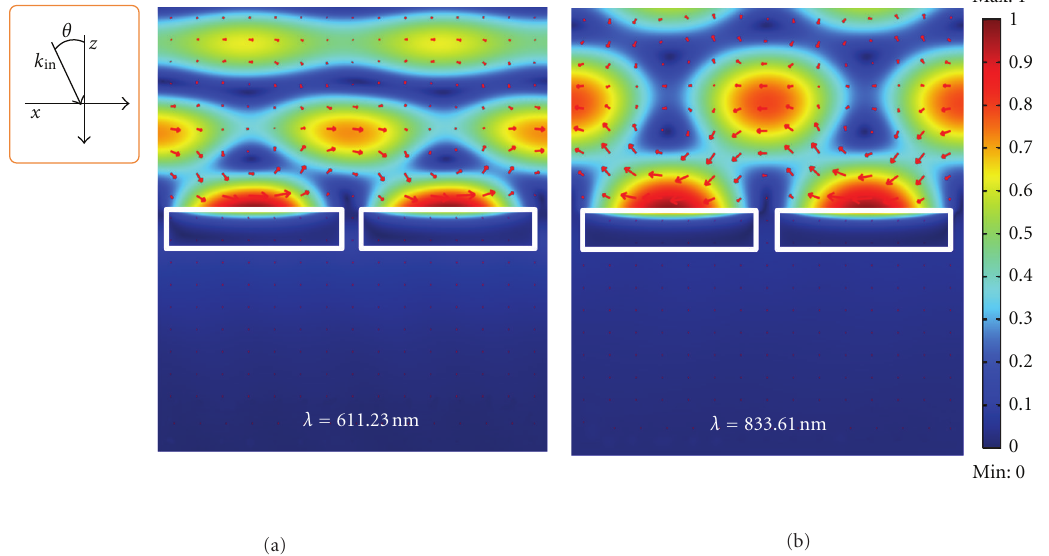
Figure 6: Absolute value of the magnetic field for the structure described in Figure 5 with θ = 10 ◦ computed at (a) λ = 611.23 nm and (b) λ = 833.61 nm. Red arrows in both plots express the Poynting vector direction.